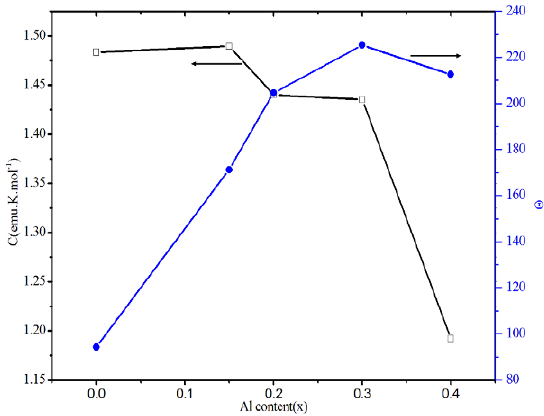
Al O for 0 ≤ x ≤ 0.4 1-x x 2